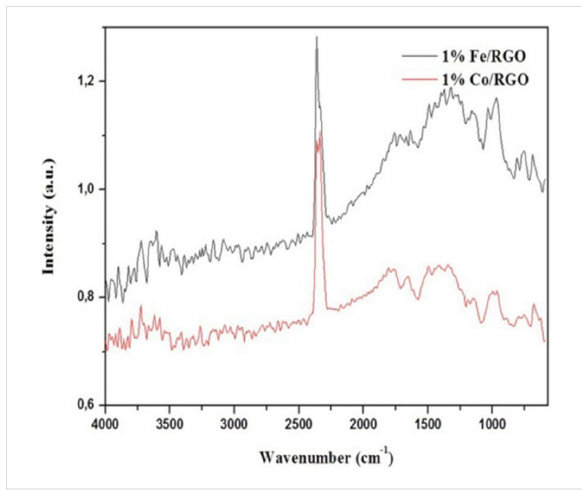
Figure 5: IR spectra of 1% Fe/RGO and 1% Co/RGO catalysts collected by using diffuse reflectance infrared transform spectroscopy (DRIFT) at room